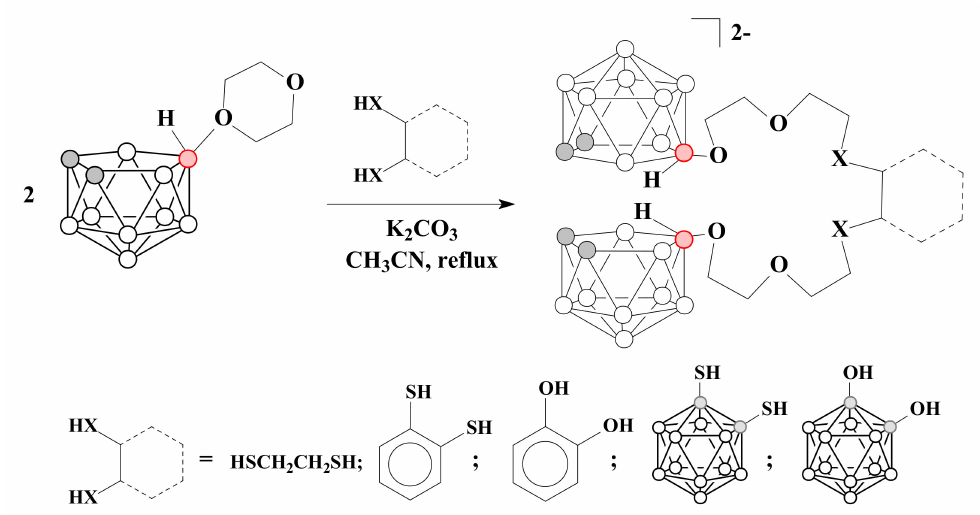
Scheme 7. The synthesis of nido -carborane-based podands. The reaction of two equivalents of 1,4-dioxane derivative of nido -carborane with resorci- nol proceeds in a similar way, resulting in K 2 [1,3-(10-OC 2 H 4 OC 2 H 4 O-7,8-C 2 B 9 H 11 ) 2 C 6 H 4 ], whereas the reaction with hydroquinone leads to two products K 2 [1,4-(10-OC 2 H 4 OC 2 H 4 O-